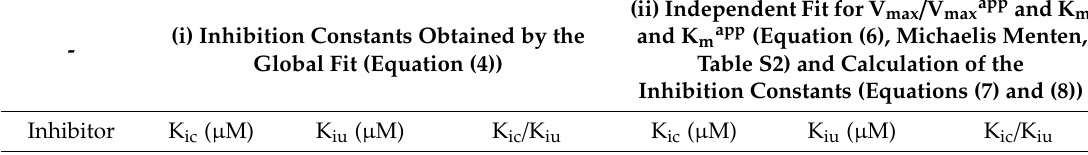
Table 1. Inhibition constants K ic and K iu for anthocyanin-3-glycosides calculated by two di ff erent